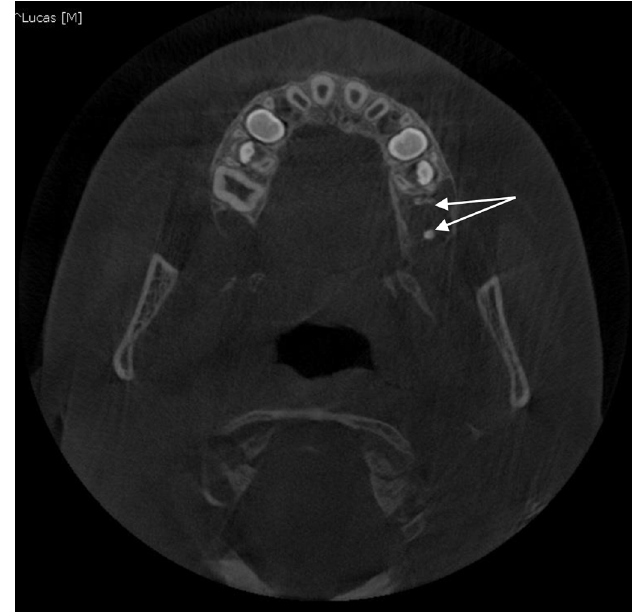
Fig. 3. Axial section of the cone beam: dental inclusion (white arrows) at the site of tooth 26.